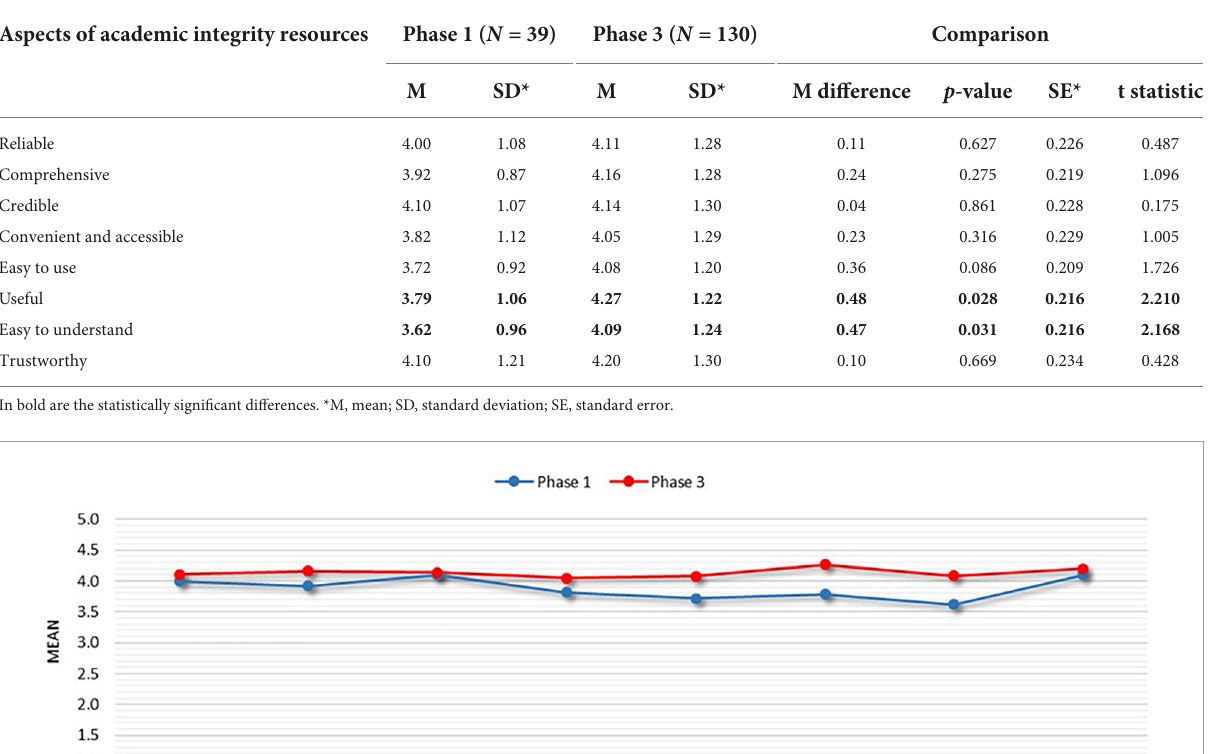
TABLE 2 Mean values of the eight aspects of academic integrity resources before (phase 1) and after (phase 3) implementation of the new academic integrity